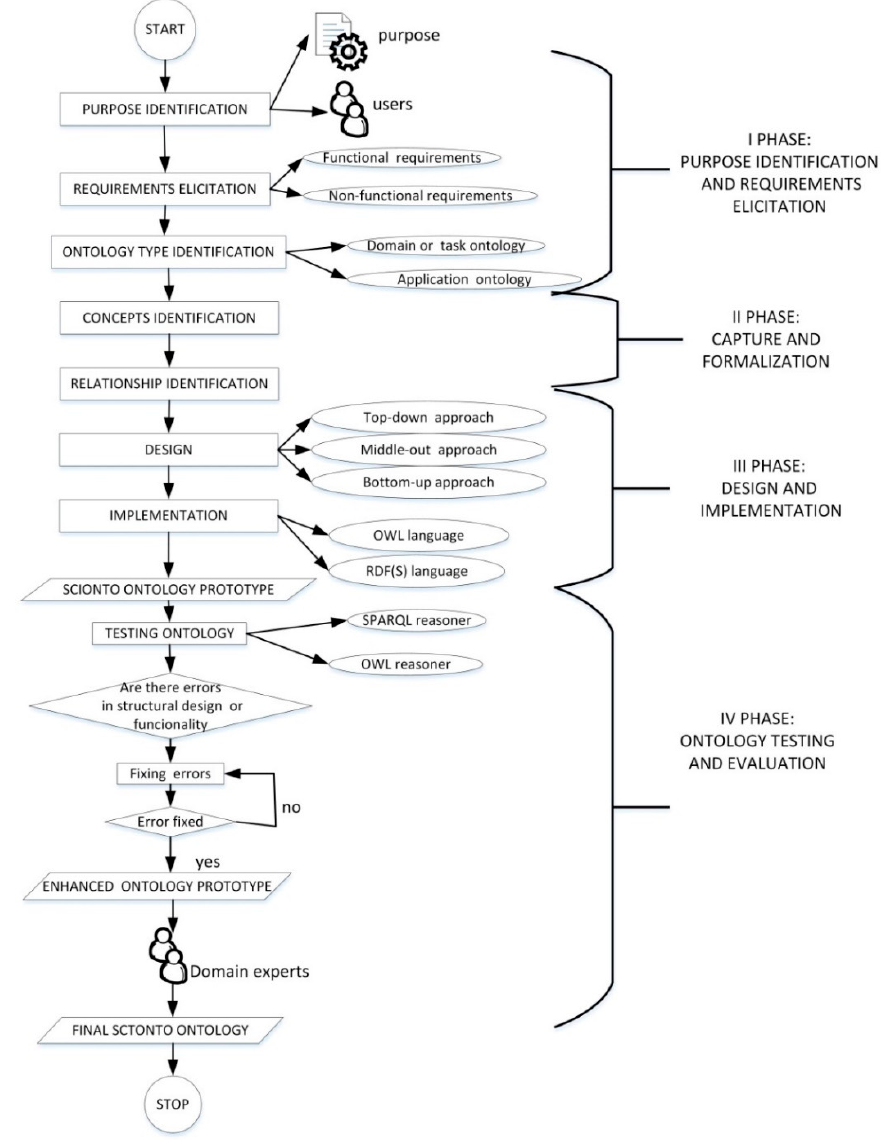
Figure 1. Workflow for the development of the SCTonto ontology.